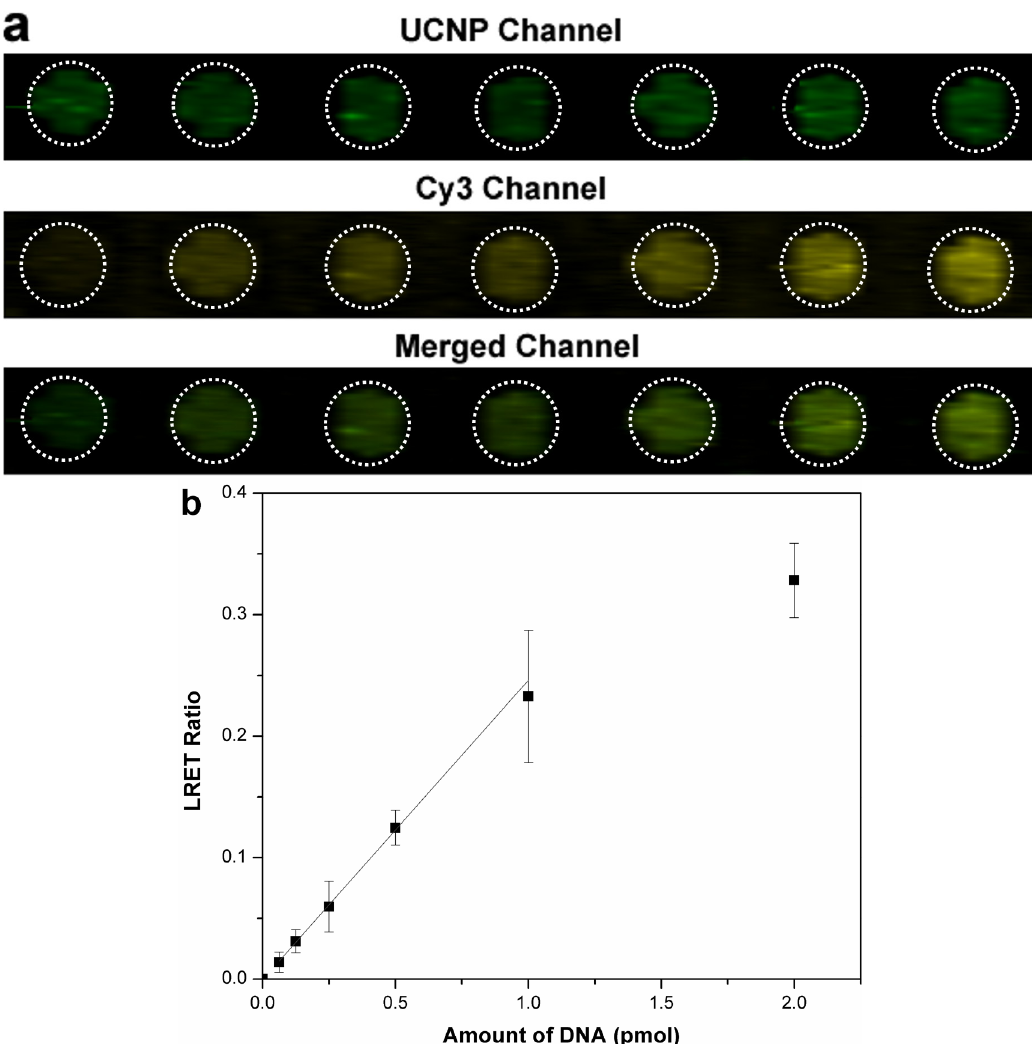
Figure 3. Quantification of un-labeled target DNA by LRET-sensitized sandwich assay using UCNPs to excite Cy3-labeled reporter DNA. ( a ) Pseudocolor